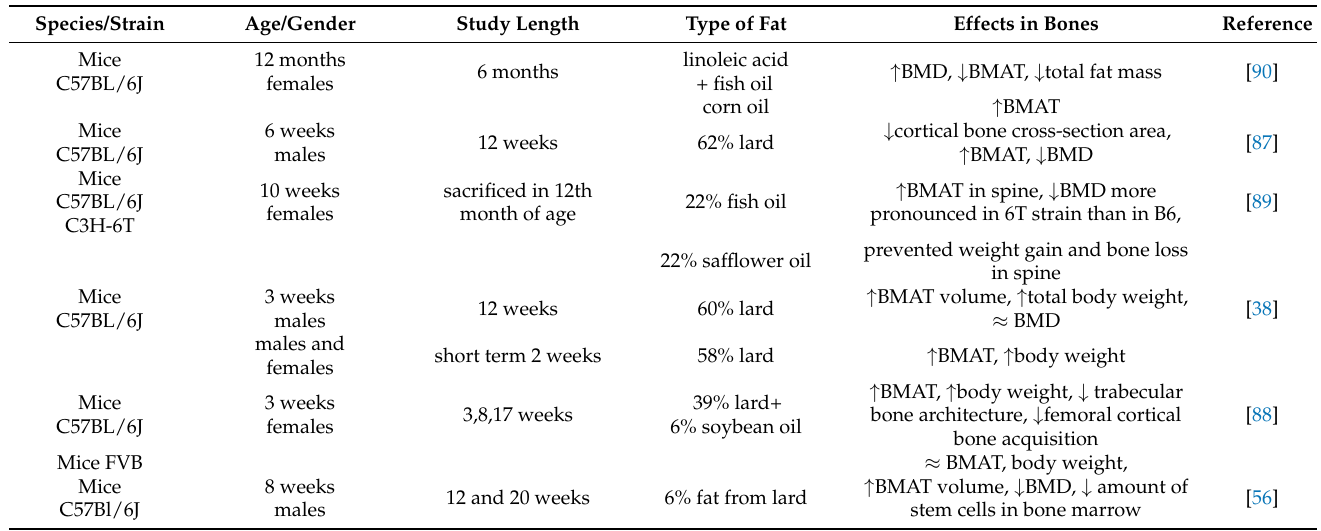
Table 2. Differences in BMAT due to different types of fat in the diet and strain of animals used in the study. Species/Strain Age/Gender Study Length Type of Fat Effects in Bones